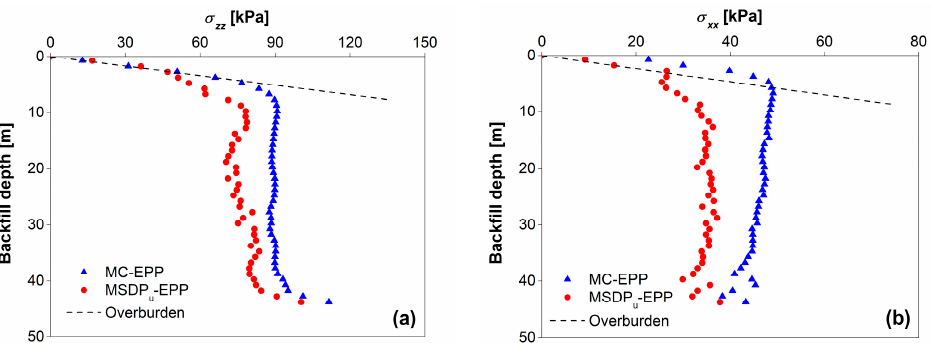
Figure 15. Stress distributions along the centerline (CL) of the backfilled stope with the MSDP u ‐ EPP model and the MC-EPP model obtained by FLAC3D for ( a ) vertical stress σ zz and ( b ) horizontal stress σ xx.